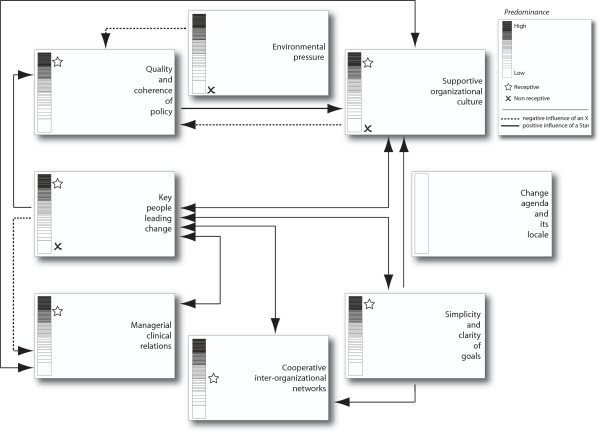
Role model case.